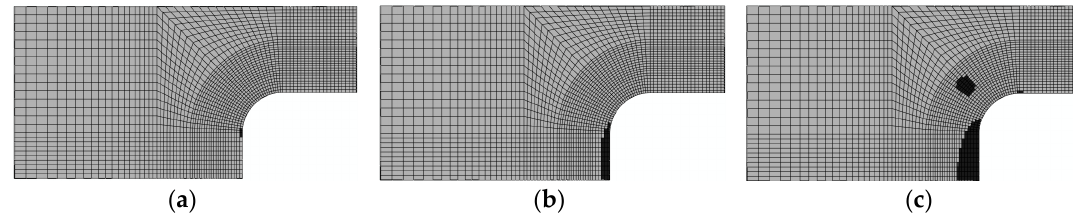
Figure 9. Fracture damage of unrepaired fiber ( − 45°): ( a ) 108.5 kN; ( b ) 137.3 kN; and ( c ) 192.3 kN.